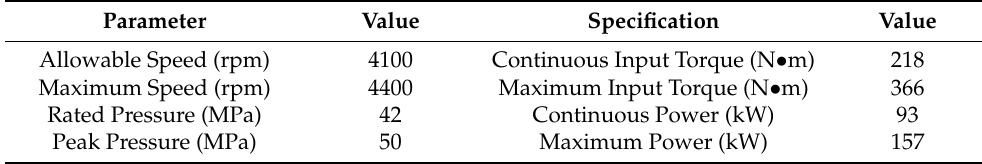
Table 3. Main technical specifications of the constant motor of the HMF-02 model (55 cm 3 /rev).